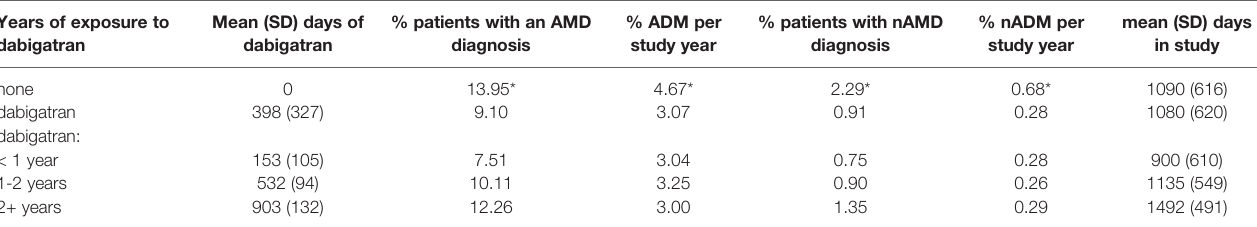
TABLE 2 | Statistical analysis of AMD and dabigatran use. Years of exposure to